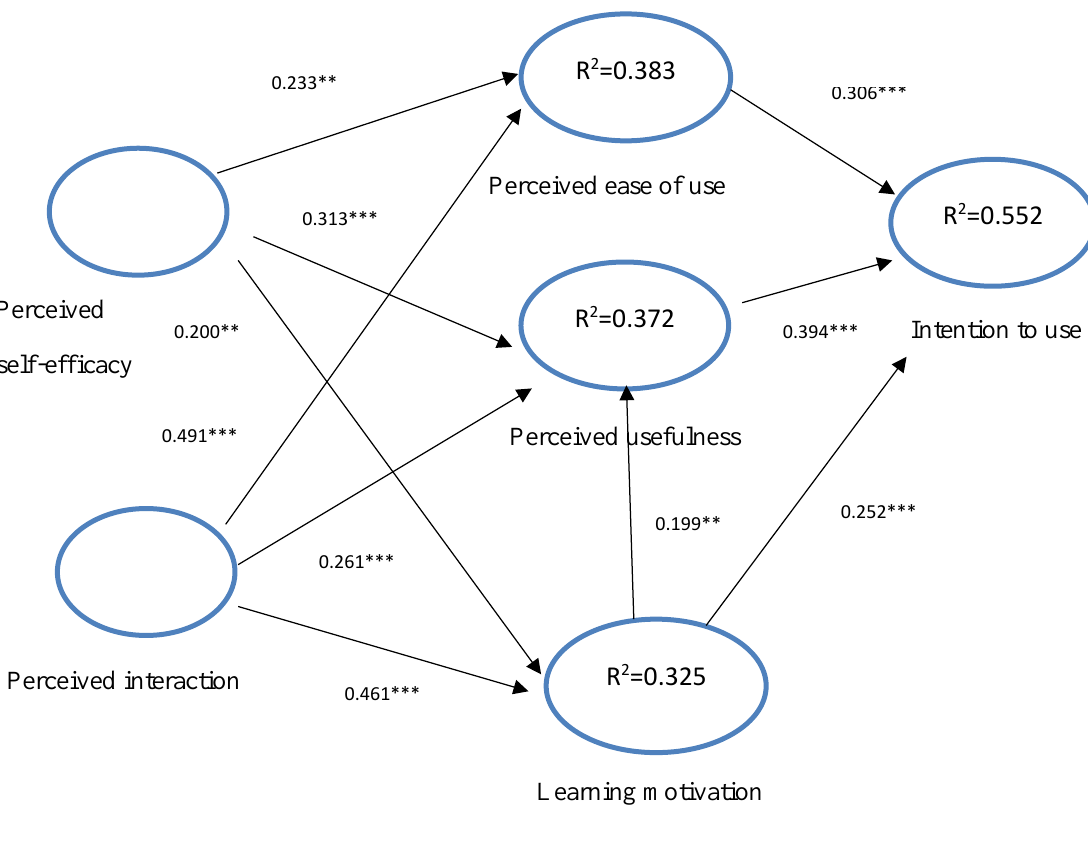
Figure 5. PLS analysis of the research model (**=P<0.01; ***=P<0.001). Perceived self-efficacy (ß=0.200, p <0.01) and perceived interaction (ß=0.461, p <0.001) are two strong predicators of learning motivation, contributing 32.5% of variance explained (R 2 =0.325). Meanwhile, perceived ease of use (ß=0.306, p <0.001), perceived usefulness (ß=0.394, p <0.001), and learning motivation (ß=0.252, p <0.001) are found to be strong predicators of learners’ intention for system use, accounting for 55.2% of variance explained (R 2